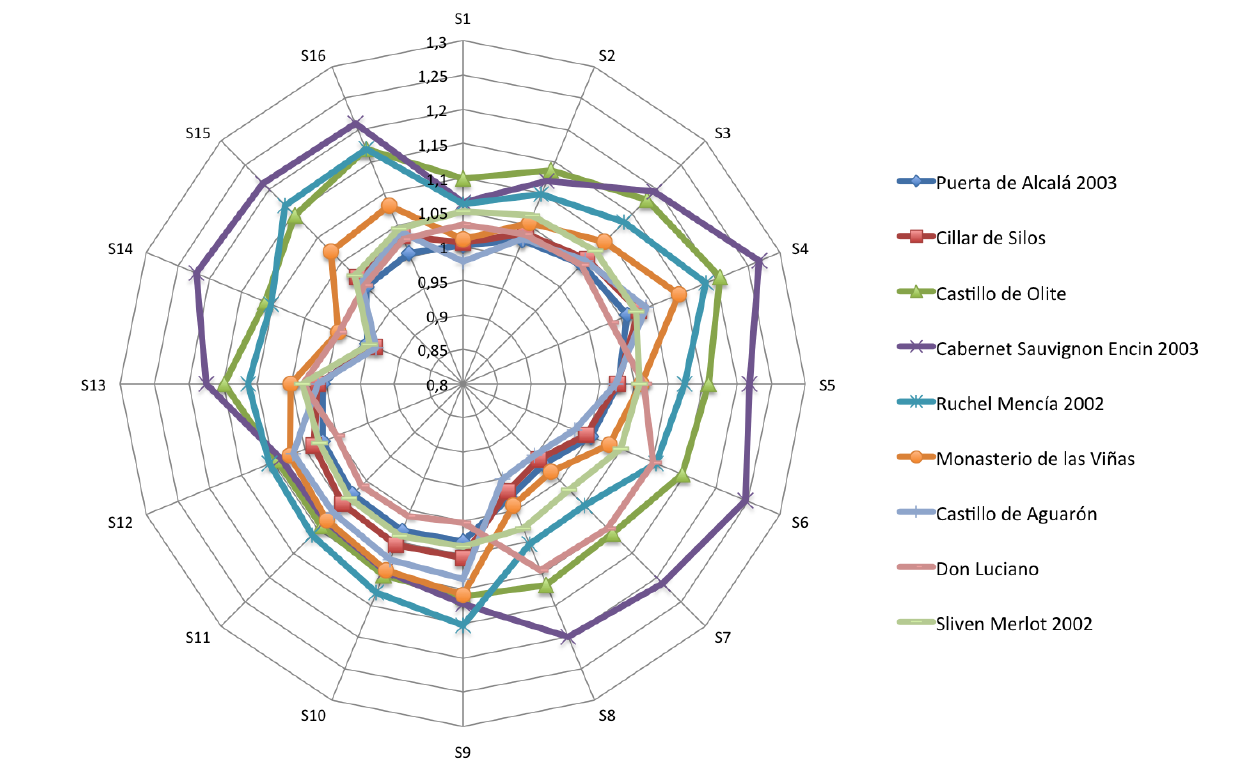
Figure 5. Polar plots of the variation in sensor resistance for the red wines.